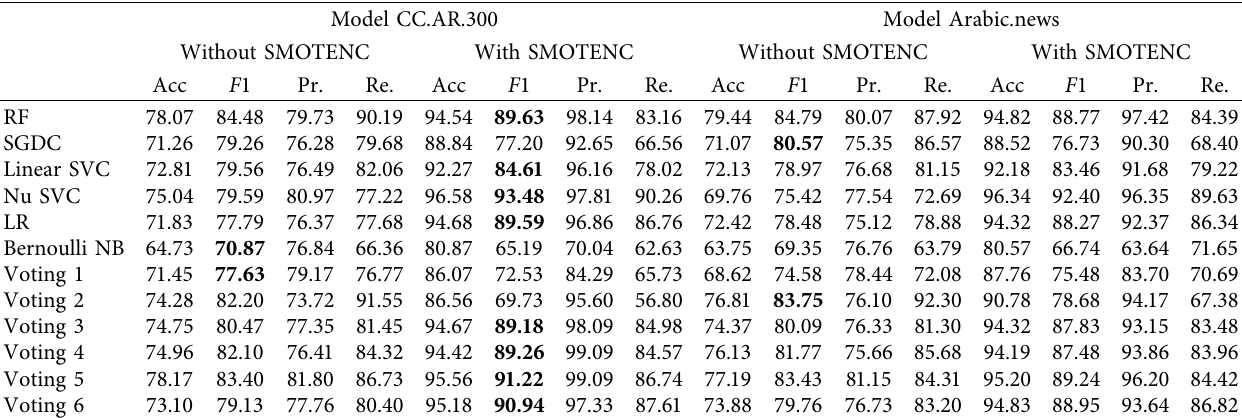
Table 3: The results of the ensemble-based and single-based classifiers using two pretrained models with and without SMOTENC. Model CC.AR.300